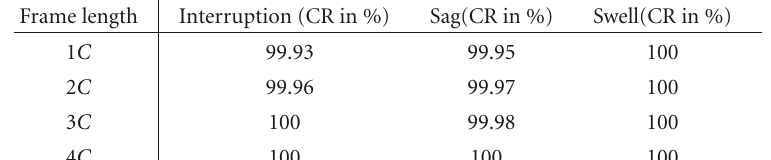
Table 1: Performance of the proposed technique to classify disturbances in the vector f .